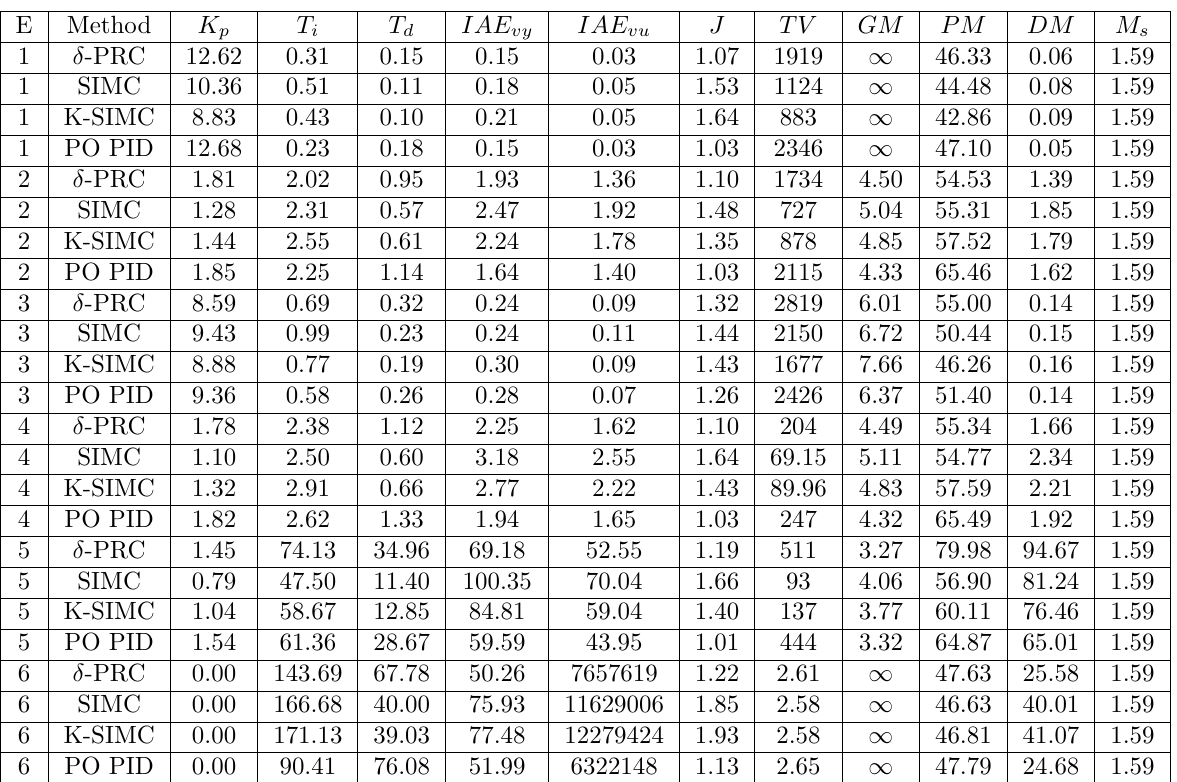
Table 6: Es1-6. The table contains the PID controller parameters for fixed robustness M s = 1 . 59 for the methods; δ -PRC, SIMC, K-SIMC and PO PID. Also include the Pareto performance J and the input usage TV . The following mar- gins are included: Gain Margin (GM), Phase Margin (PM) and Delay Margin